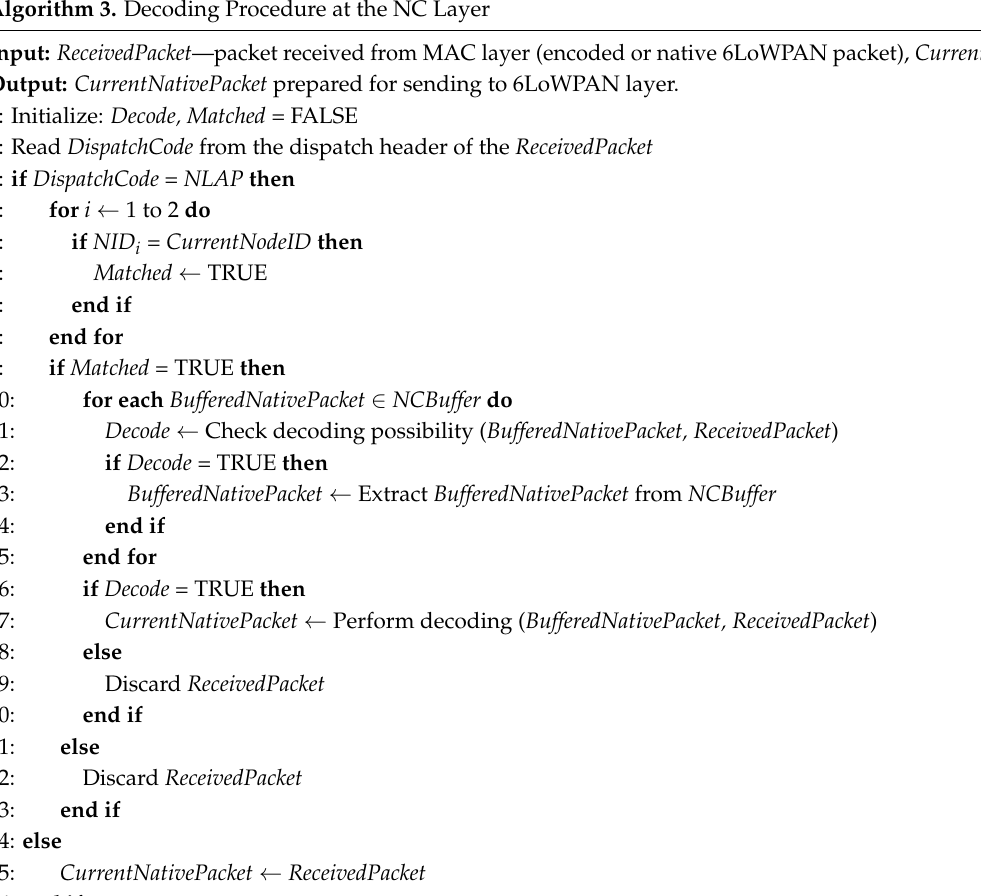
Algorithm 3. Decoding Procedure at the NC